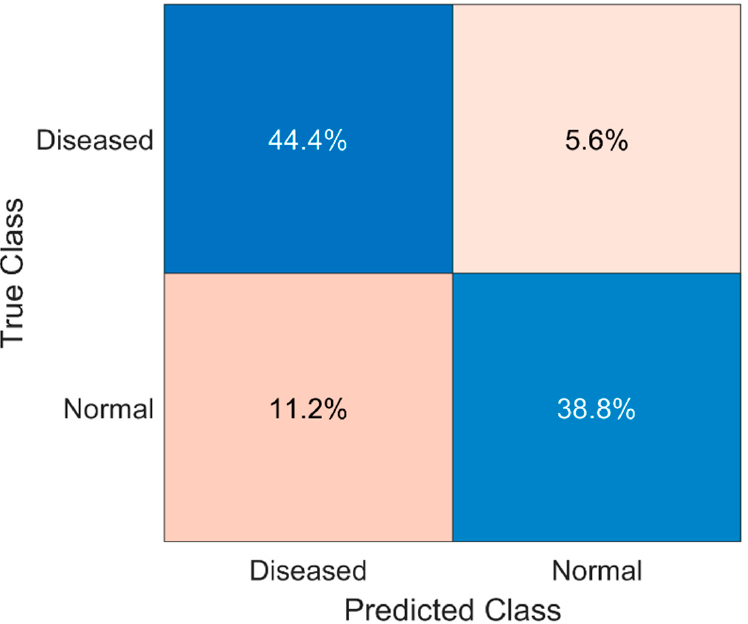
Figure 15. Confusion-matrix-based classification results with basic 3D U-Net classifier.